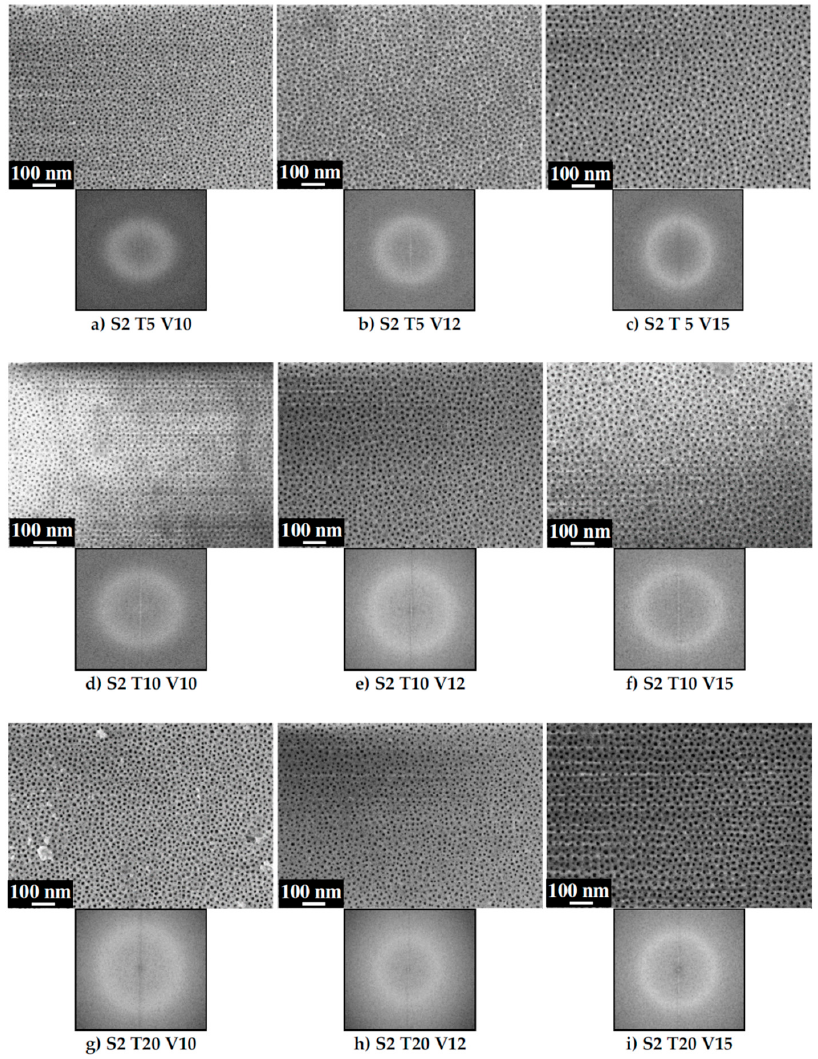
Figure 2. SEM images with their Fast Fourier Transforms of AA1050 oxide nanostructured films obtained in 2 M sulphuric acid and at different anodizing temperatures and voltages.